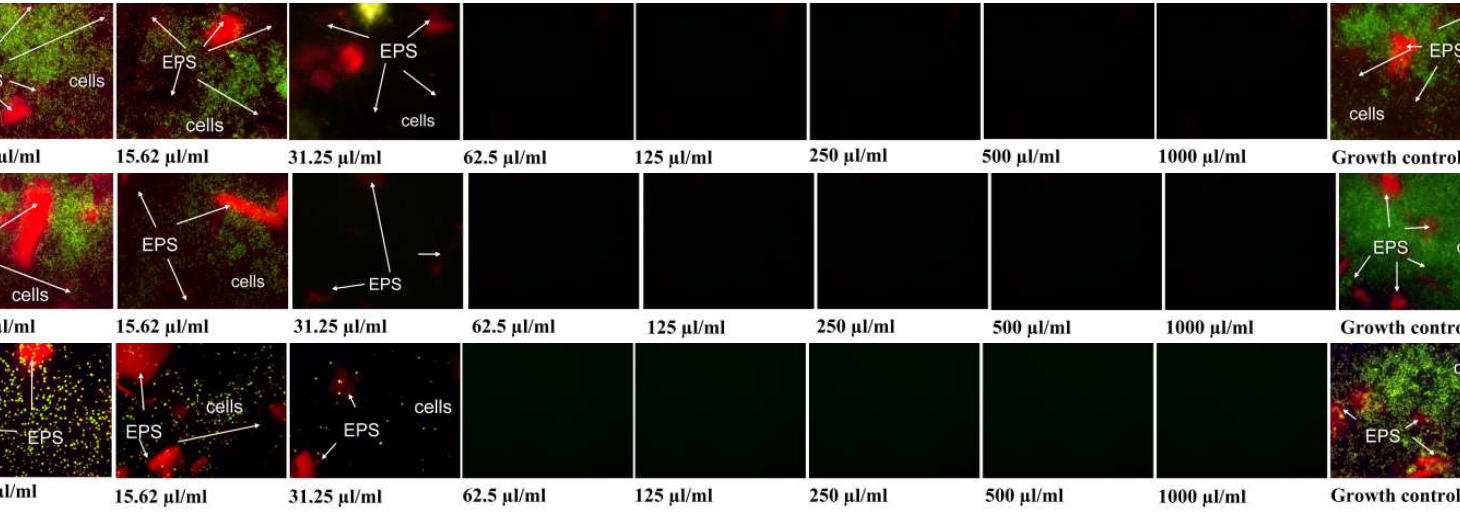
Figure 2. Influence of the test substance 2 on biofilms b) b) E. coli PMFKG-F2, d) P . mirabilis PMFKG-F4, h) S. cerevisiae PMFKG-F6. EPS – Extracellular polymer